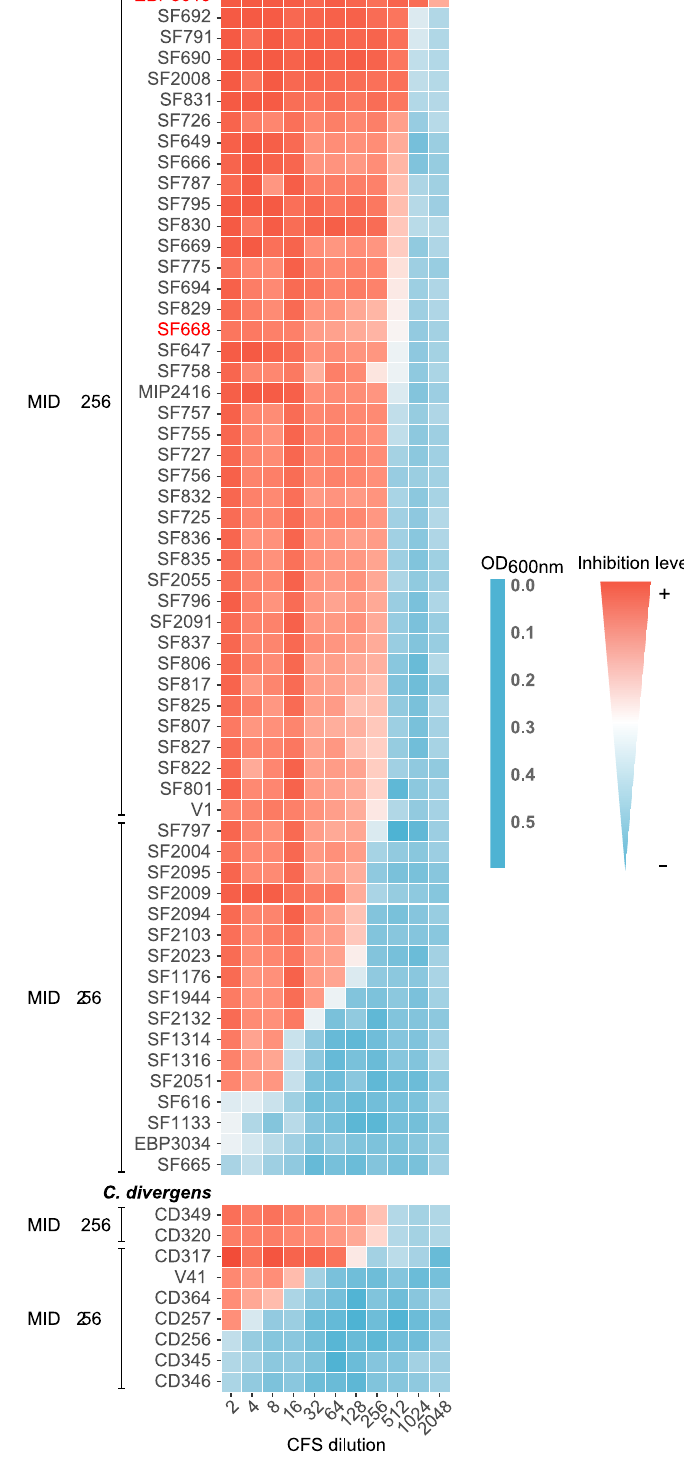
Figure 7. Cell-free supernatant (CFS) efficacy against Listeria monocytogenes RF191. The efficacy was evaluated for each strain of Carnobacterium spp. by determining their minimal dilution inhibiting the growth of Listeria monocytogenes RF191 (MID). The growth of the strain RF191 was measured through OD 600 nm . EBP3034 strain was used as a negative control. Genomes sequenced in this study are highlighted in red.